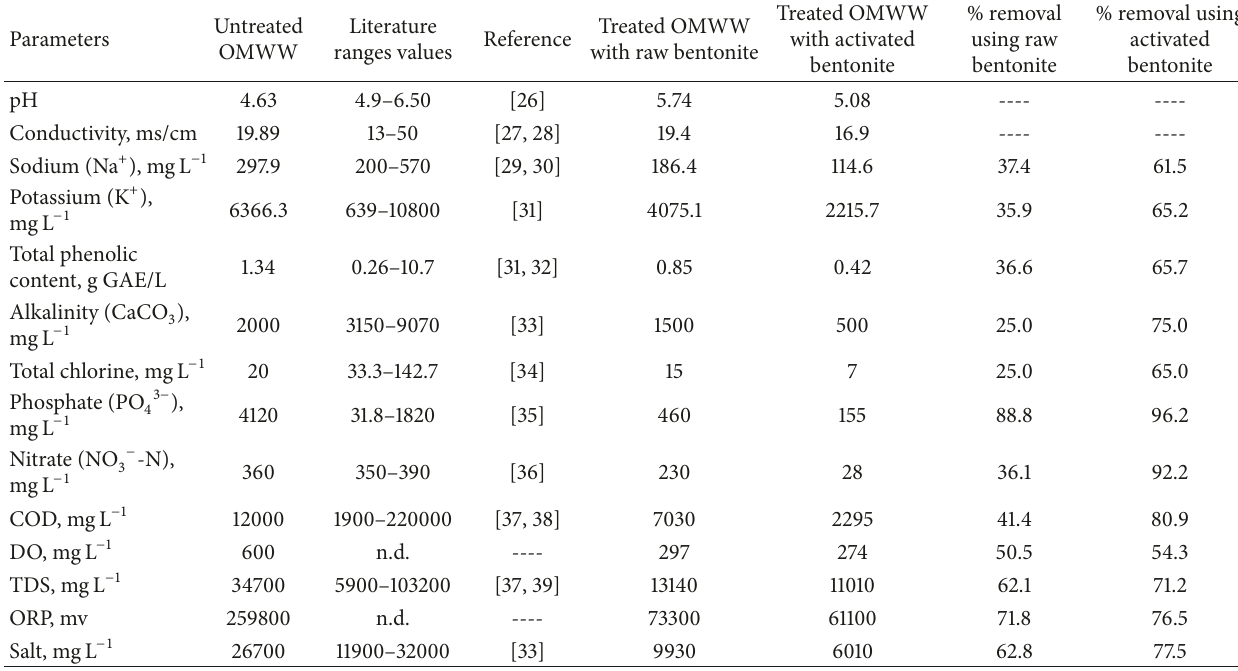
Table 1: Main characteristics of OMWW sample, untreated and treated with raw and activated